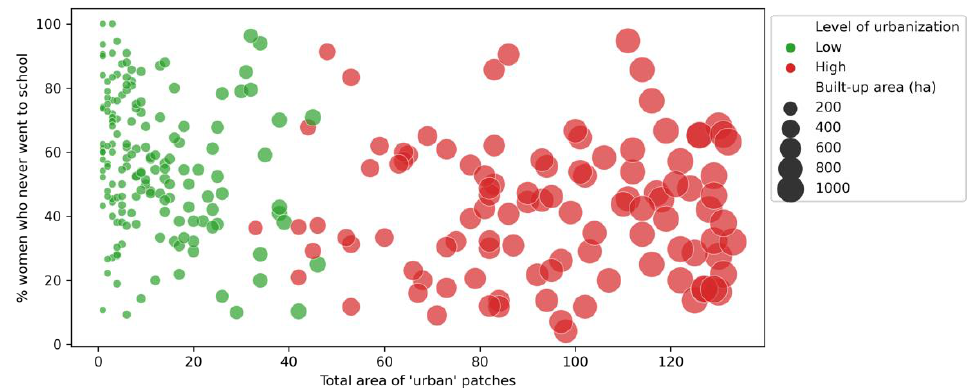
Figure 8. Relationship between the size of the urbanised area ( x -axis) and the percentage of women without any education ( y -axis), by level of urbanisation (urban subset shown in red). Elaborated by the authors.